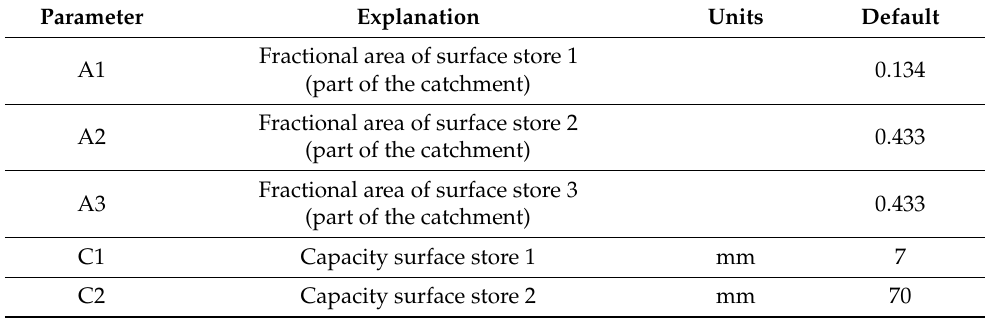
Table 2. Parameters in AWBM and their default values adapted from